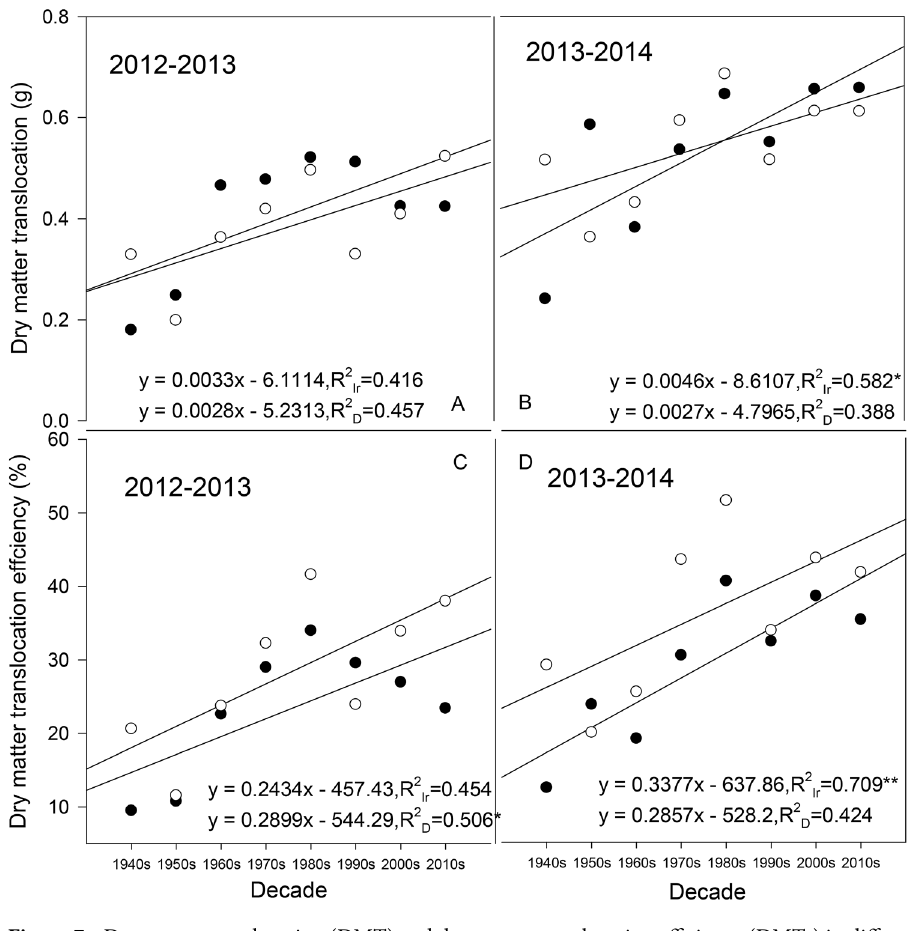
Figure 7. Dry matter translocation (DMT) and dry matter translocation efficiency (DMTe) in different cultivars. *Significant at P < 0.05; **significant at P < 0.01; Ir indicates the irrigation treatment; D indicates the drought treatment.